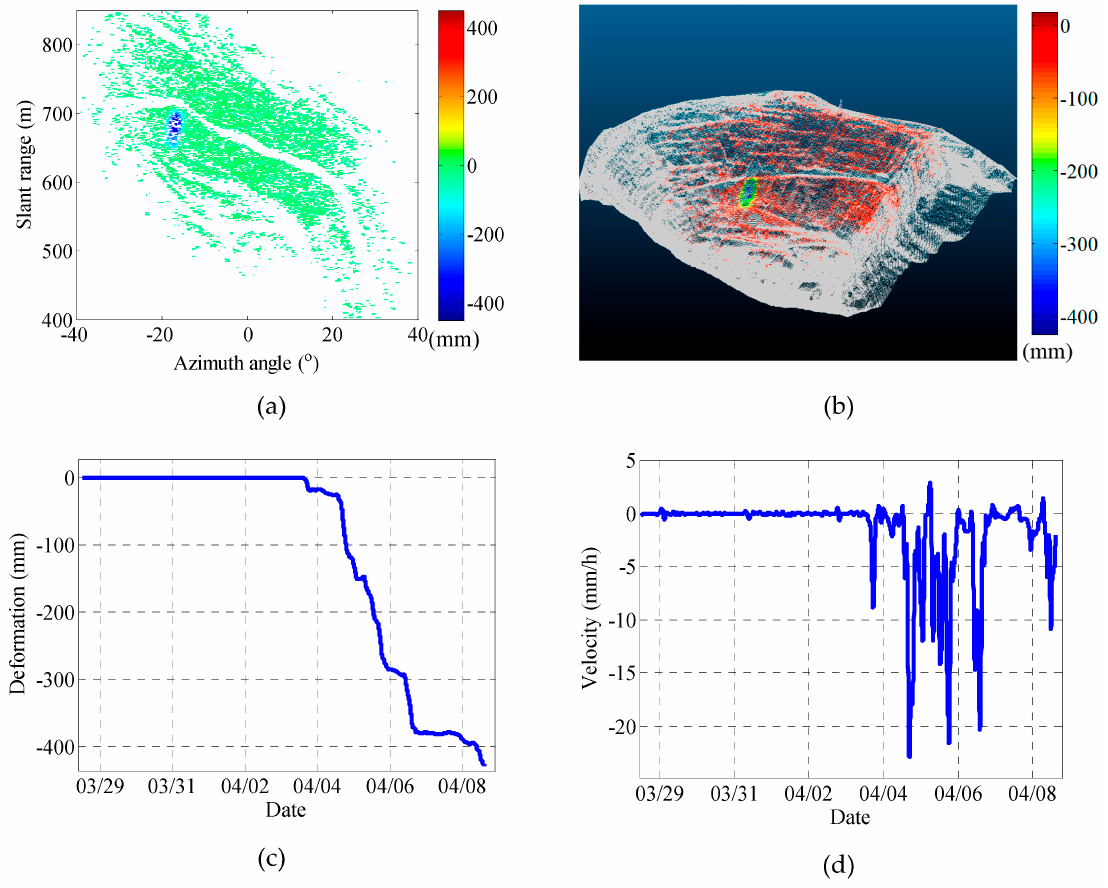
Figure 22. ( a ) Cumulative deformation map. ( b ) Deformation map shown on a 3D terrain cloud. ( c ) Deformation measurement curve. ( d ) Velocity measurement